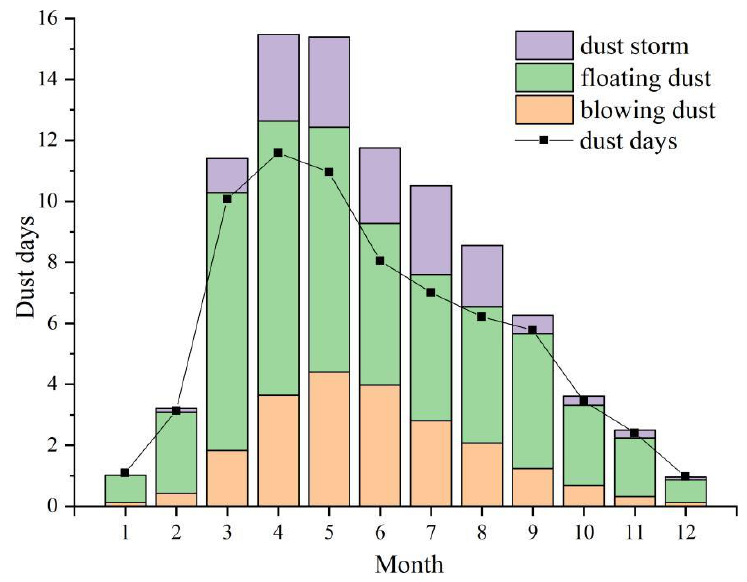
Figure 3. Average monthly variation in dust weather days.